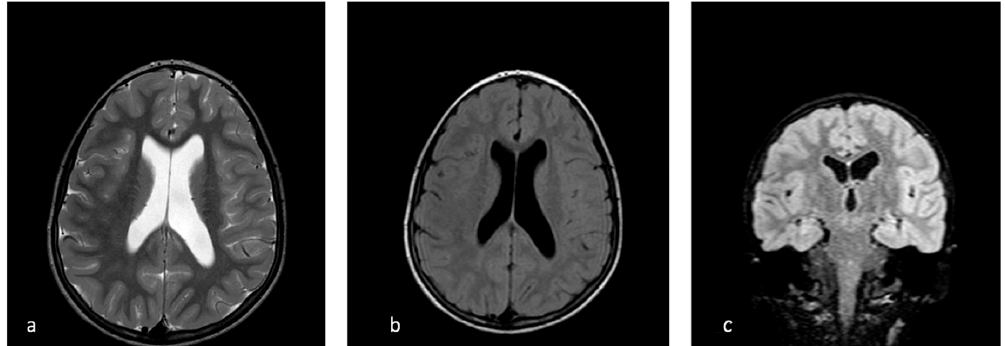
Figure 1. Ventricular asymmetry (left > right) in axial T2 weighted sequence (1a), axial T2 FLAIR sequence (1b) , and coronal multi planar rendering (1c).